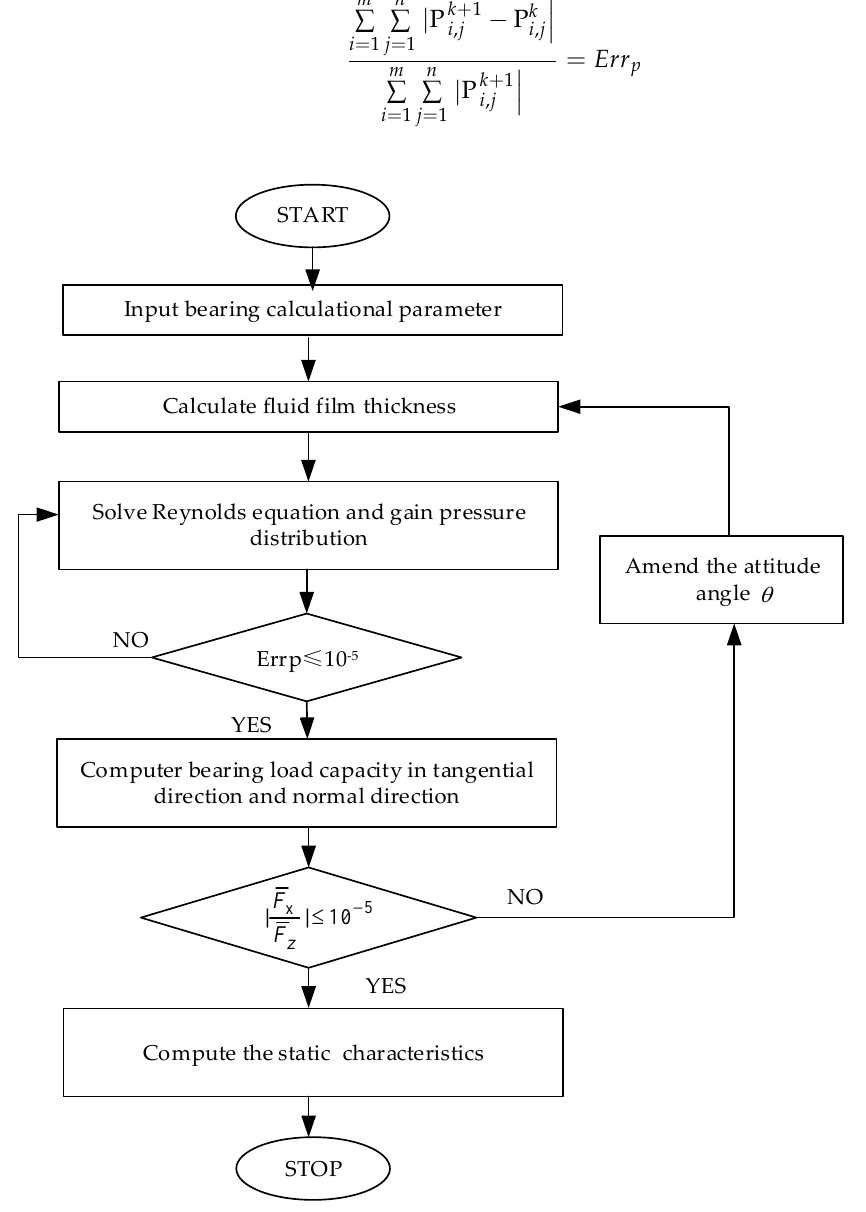
Figure 2. A flow chart to illustrate the solution procedure.